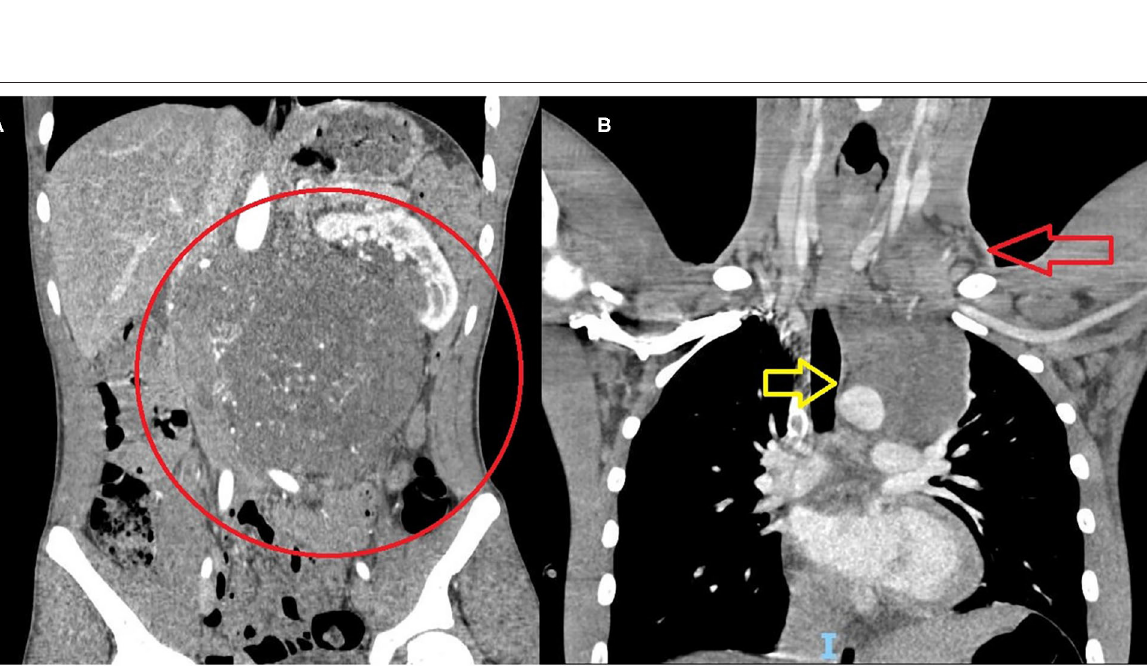
Frontiers in Pediatrics |